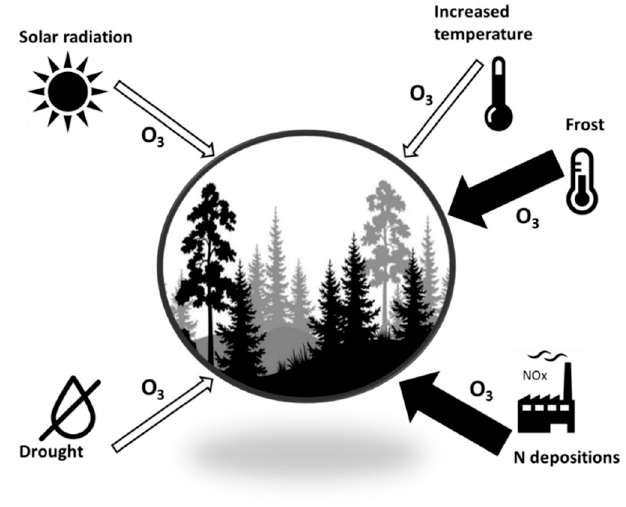
Figure 4. The scheme of potential interactive effects of O 3 and other environmental factors. Thin open arrows indicate an amelioration of negative O 3 effects; thick dark arrows indicate an enhancement of O 3 effects on plants/trees.